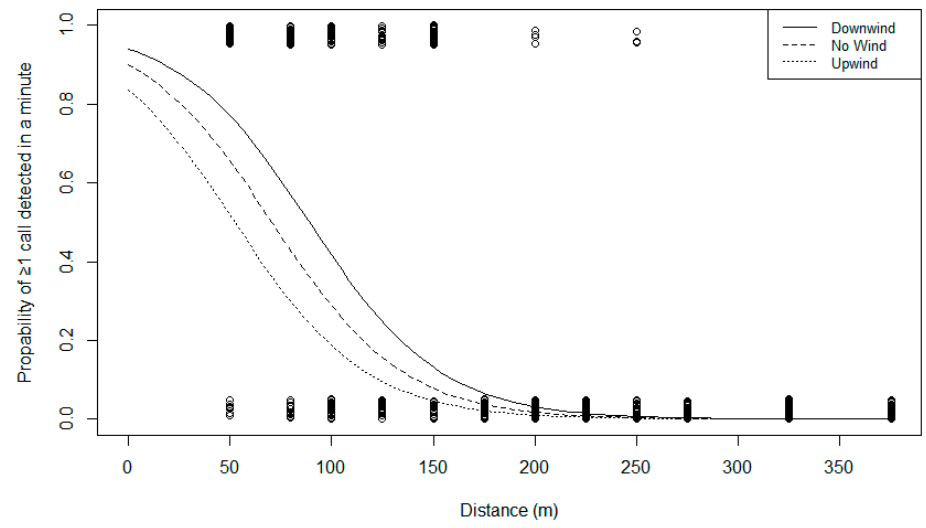
Figure 5. Fitted logistic regression of the probability of at least one of ten sheep calls in a minute of acoustic data being detected using the sheep/goat detection algorithm, plotted as a function of the acoustic sensor’s distance to the calling animals. The regression is plotted for wind values of 0 (downwind), 0.5 (no wind), and 1 (upwind).